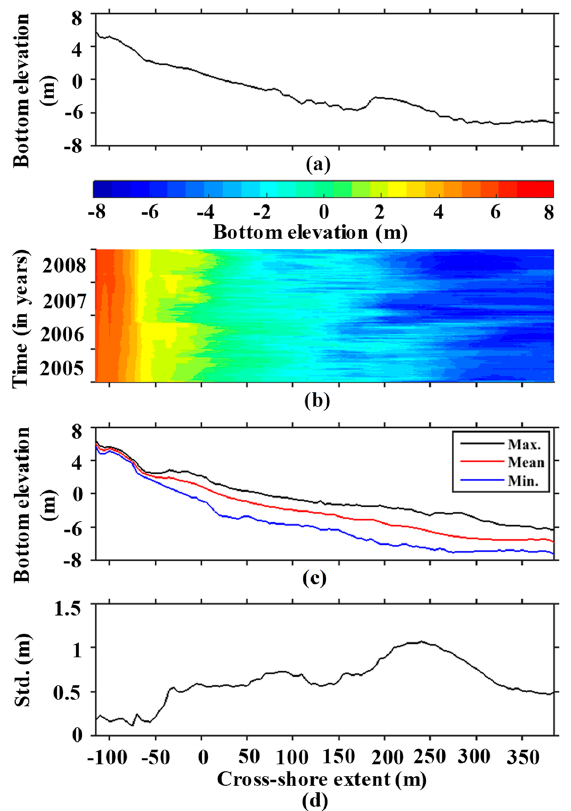
Figure 4. ( a ) An example of the beach profile variation along the pier (18 April 2005 at 7:00 am); ( b ) the beach profile variation during 2005–2008; ( c ) the mean, minimum, and maximum range of the beach profile; and ( d ) the standard deviation.